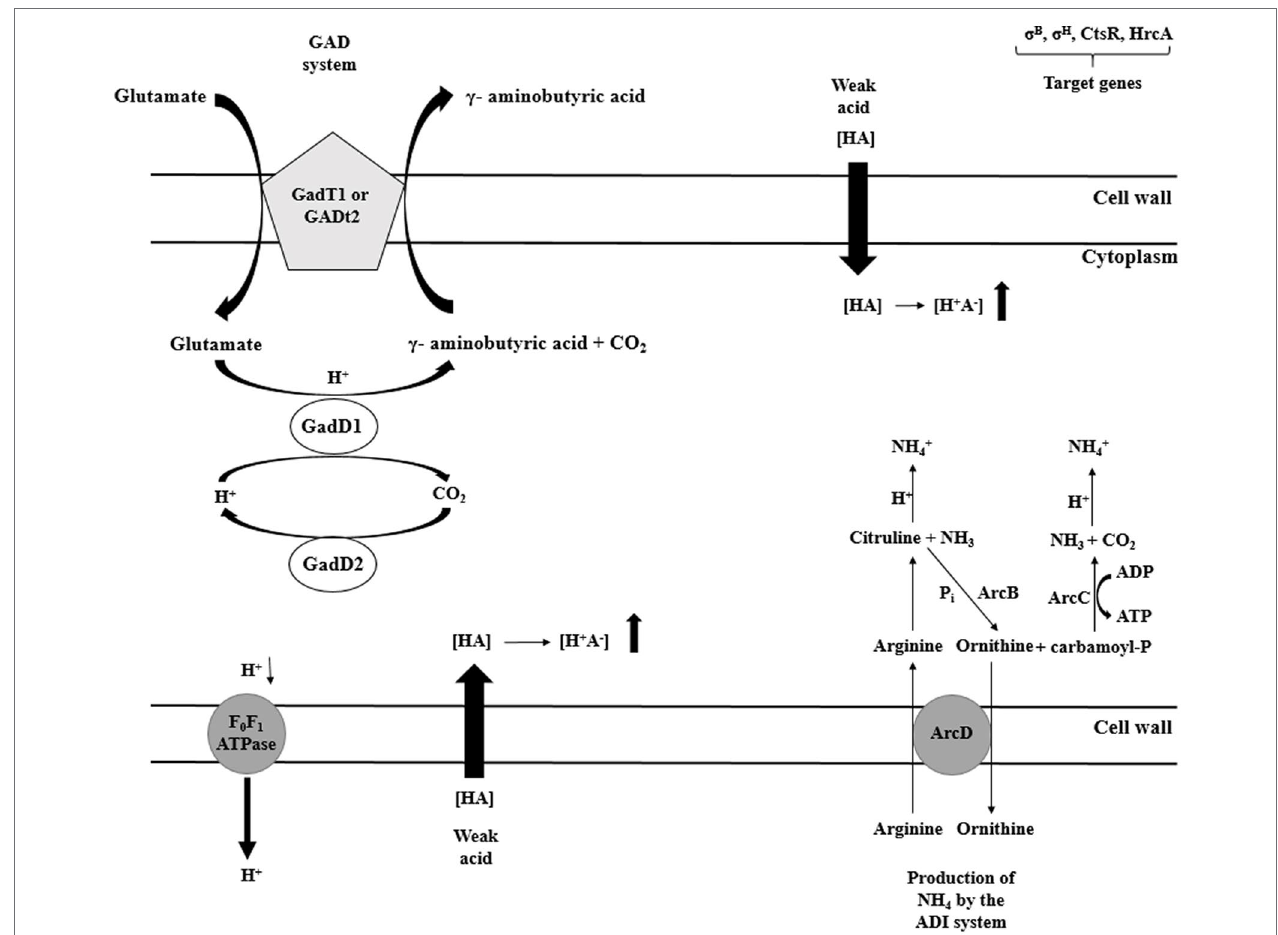
FIGURE 7 | Selected mechanisms of acid stress response of L. monocytogenes (GAD – glutamate decarboxylase system; ADI – arginine deiminase system; HrcA – Heat-inducible transcription repressor; CtsR – negative transcription regulator; ArcA – arginine deiminase; ArcB – catabolic ornithine carbamoyltransferase; ArcC – carbamate kinase; ArcD – membrane-bound arginine-ornithine antiporter; and F 0 F 1 –ATPase – proton efflux membrane